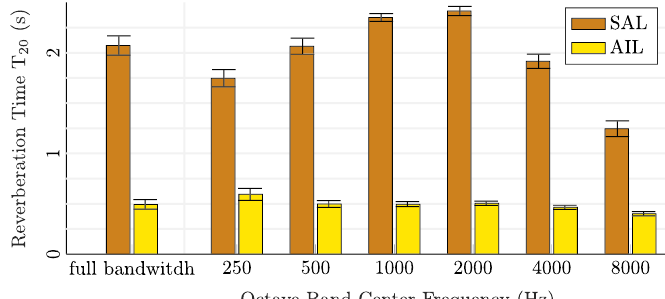
Fig. 12 Reverberation time T 20 for the two rooms SAL and AIL at full bandwidth and in different octave bands. The error bars indicate the standard deviation of the estimate across all possible loudspeaker-microphone